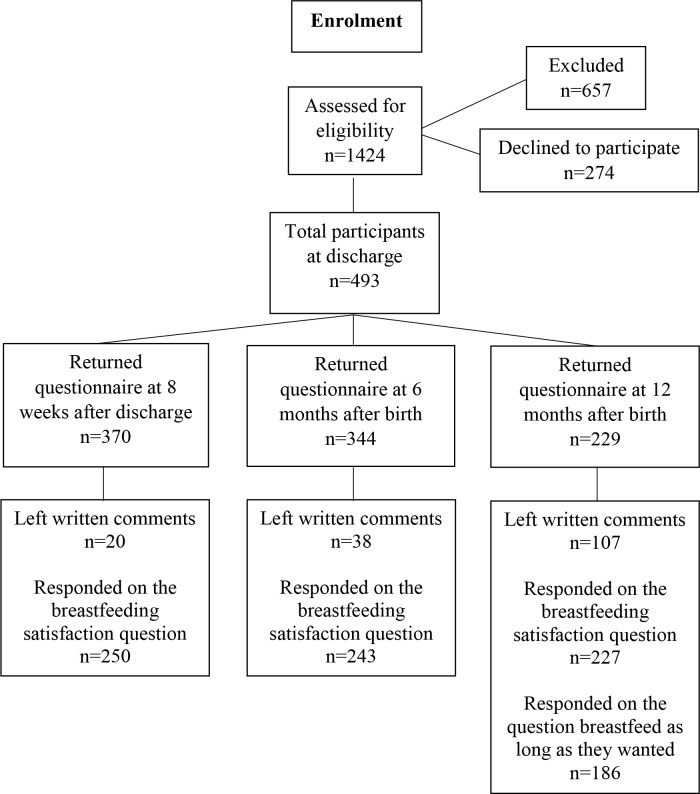
Flowchart.A flowchart over the enrolment in the study.